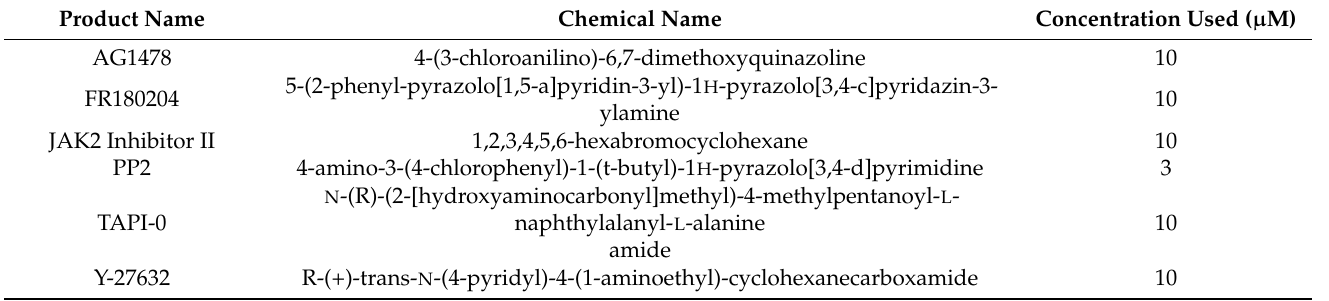
Table 1. Inhibitors used in this